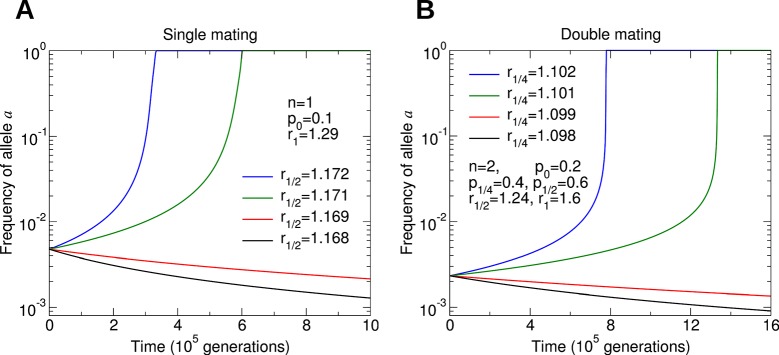
Numerical simulations of the evolutionary dynamics nicely illustrate the conditions specified by Equations 1 and 2.The sterility allele is recessive. For numerically probing invasion, we use the initial condition XA⁢A,0=1-10-2 and XA⁢A,1=10-2. We set r0 = 1. A: Single mating, n = 1. Parameters p0 = 0.1 and r1 = 1.29. B: Double mating, n = 2. Parameters p0 = 0.2, p1/4 = 0.4, p1/2 = 0.6, r1/2 = 1.24 and r1 = 1.6.